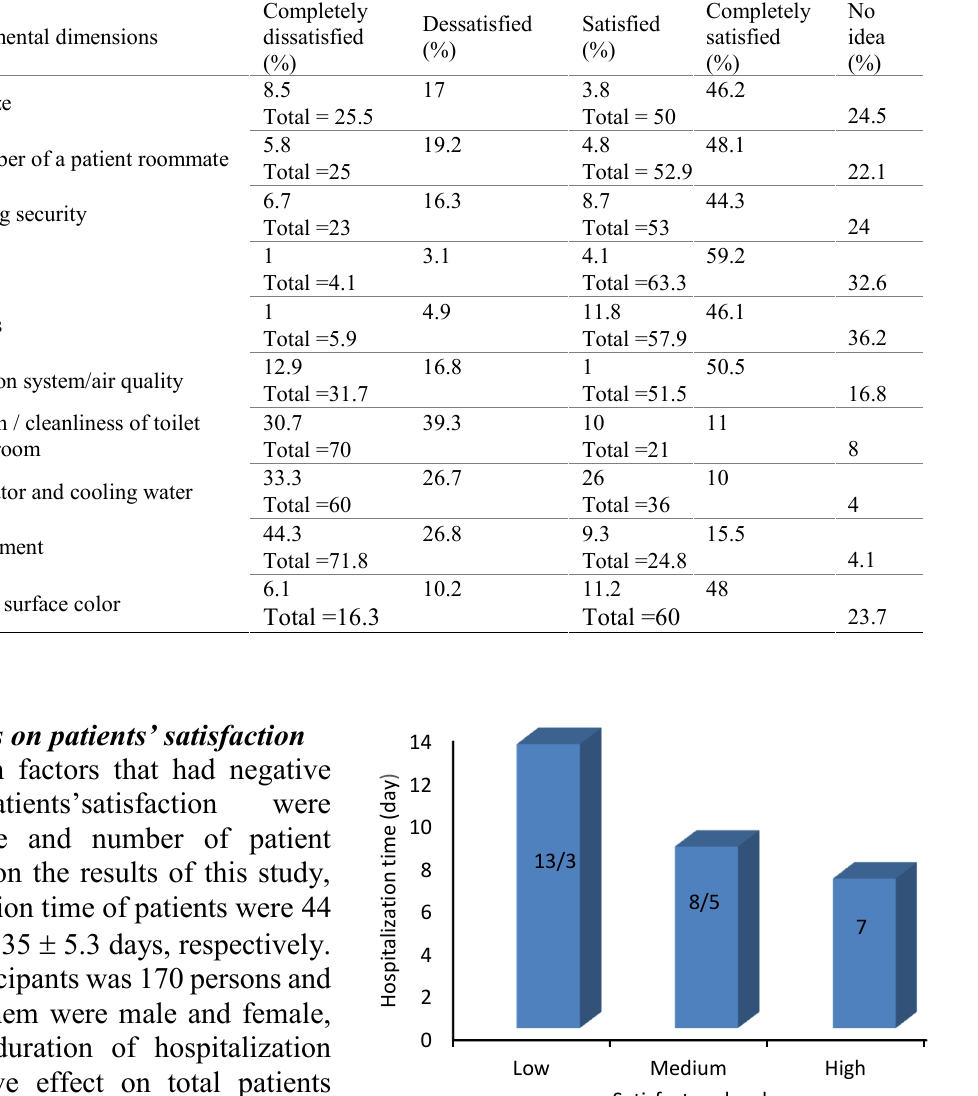
Table 2. The patients’satisfaction with indoor environmental dimensions in the chosen hospital